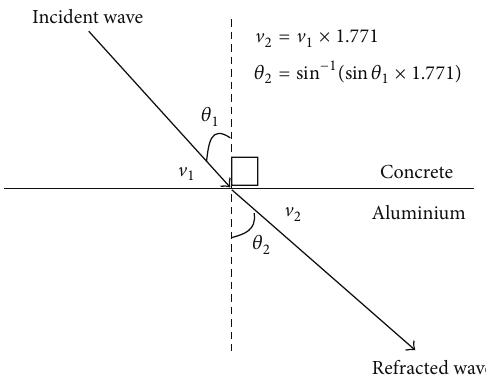
Figure 15: Refraction of wave from concrete medium to aluminium medium.